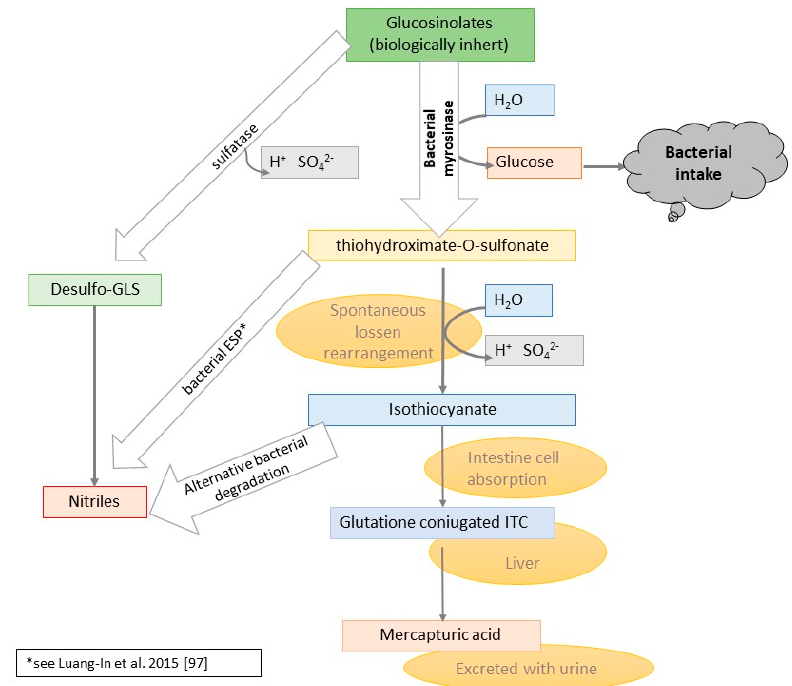
Figure 5. Scheme of GLS breakdown products by human microbiota and their adsorption in the large intestine. The steps directly involving bacterial activity are evidenced in bold.